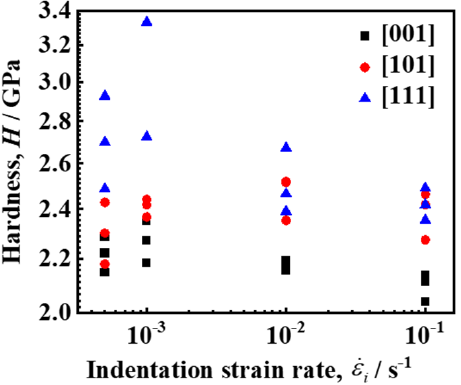
Figure 5. The relation between the hardness and indentation strain rate measured from the CSR tests in [001]-, [101]- and [111]-oriented grains.